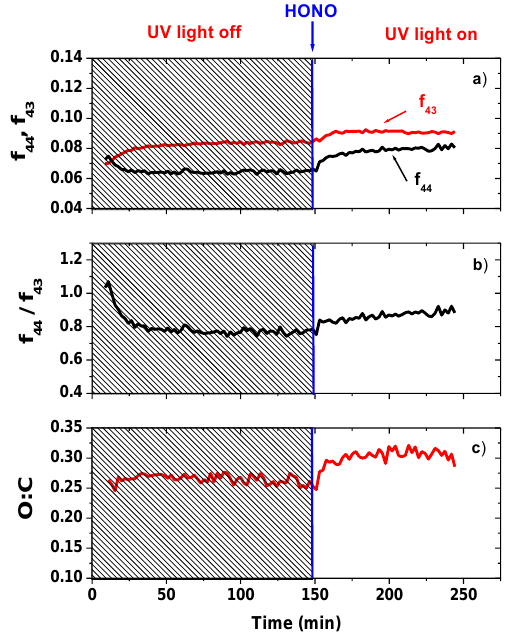
Figure 6. (a) The time series of fragments 43 and 44. (b) The ra- tio of the two fragments as a function of time. (c) The oxygen-to- carbon ratio of the particles as a function of time for Experiment 31. The shaded part indicates the period when the UV light was off, and the other section represents the period when the UV light was on. Also shown is the time when HONO was injected into the